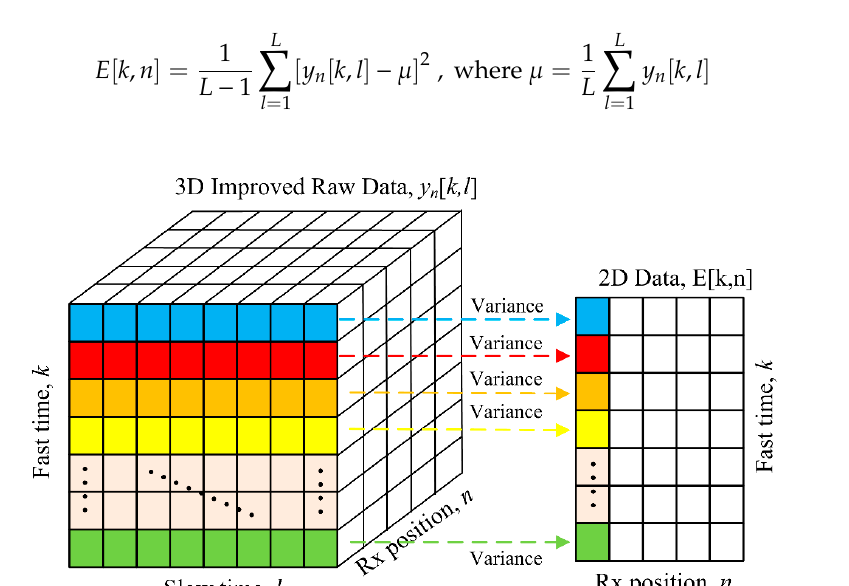
Figure 5. Conversion of the 3D data (Equation (11)) to the 2D data using statistical variance analysis.